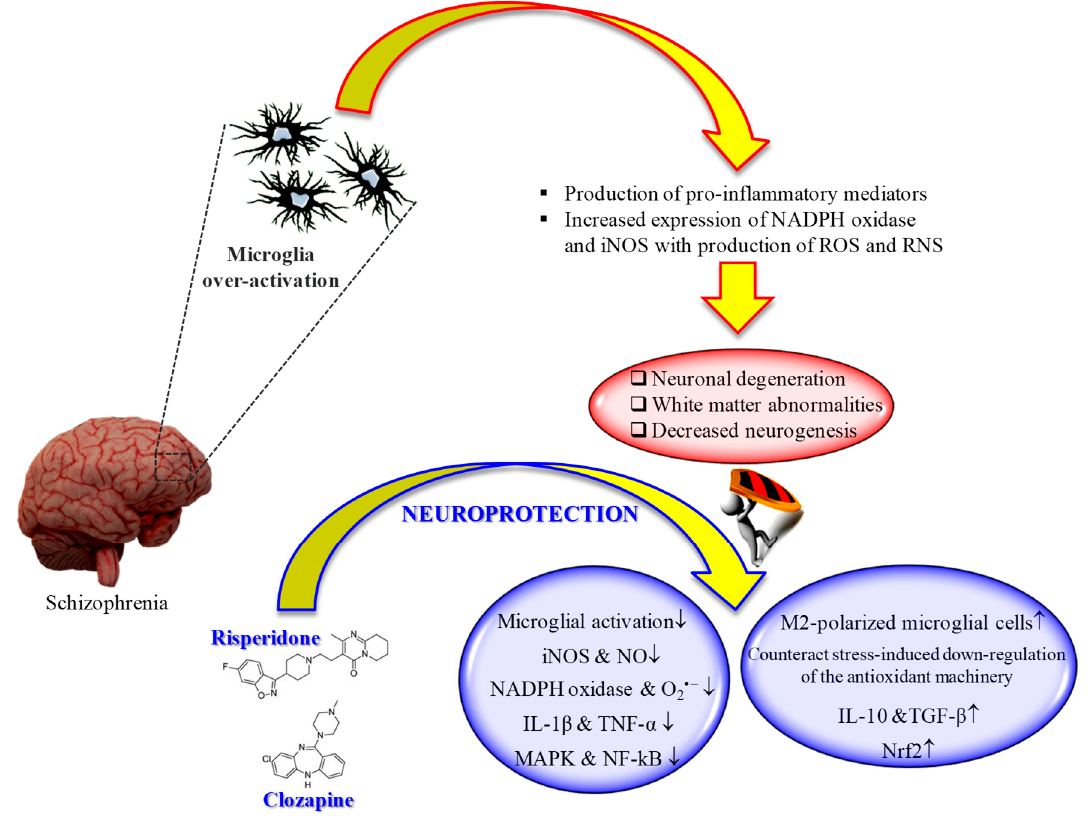
Figure 1. “Microglia hypothesis of schizophrenia”: therapeutic potential of second-generation antipsychotics. ↑ = increased; ↓ = decreased.